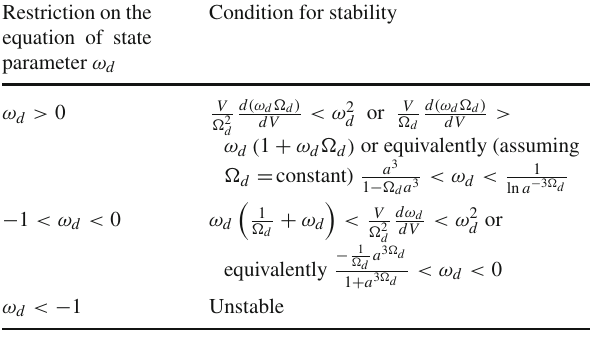
Table 1 Restrictions for stability of the system Restriction on the equation of state